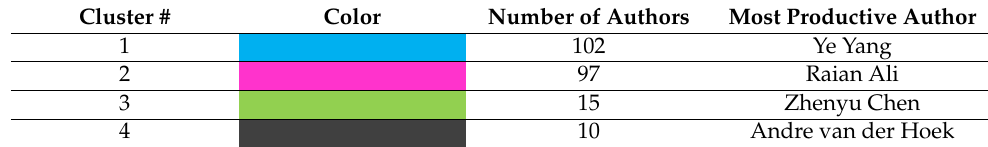
Figure 5. Community detection in the co-authorship network. Table 5. Most frequent co-authorship network clusters.